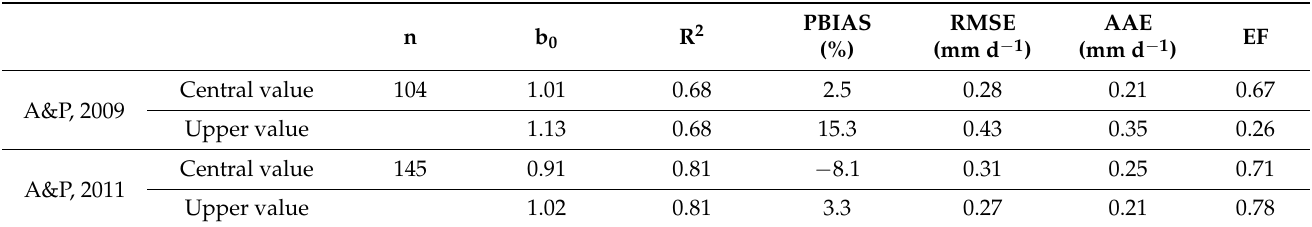
Table 7. Goodness-of-fit indicators relative to the comparison between transpiration obtained from sap-flow measurements (T SF field ) with the transpiration estimated with the A&P approach (T c act A&P ).